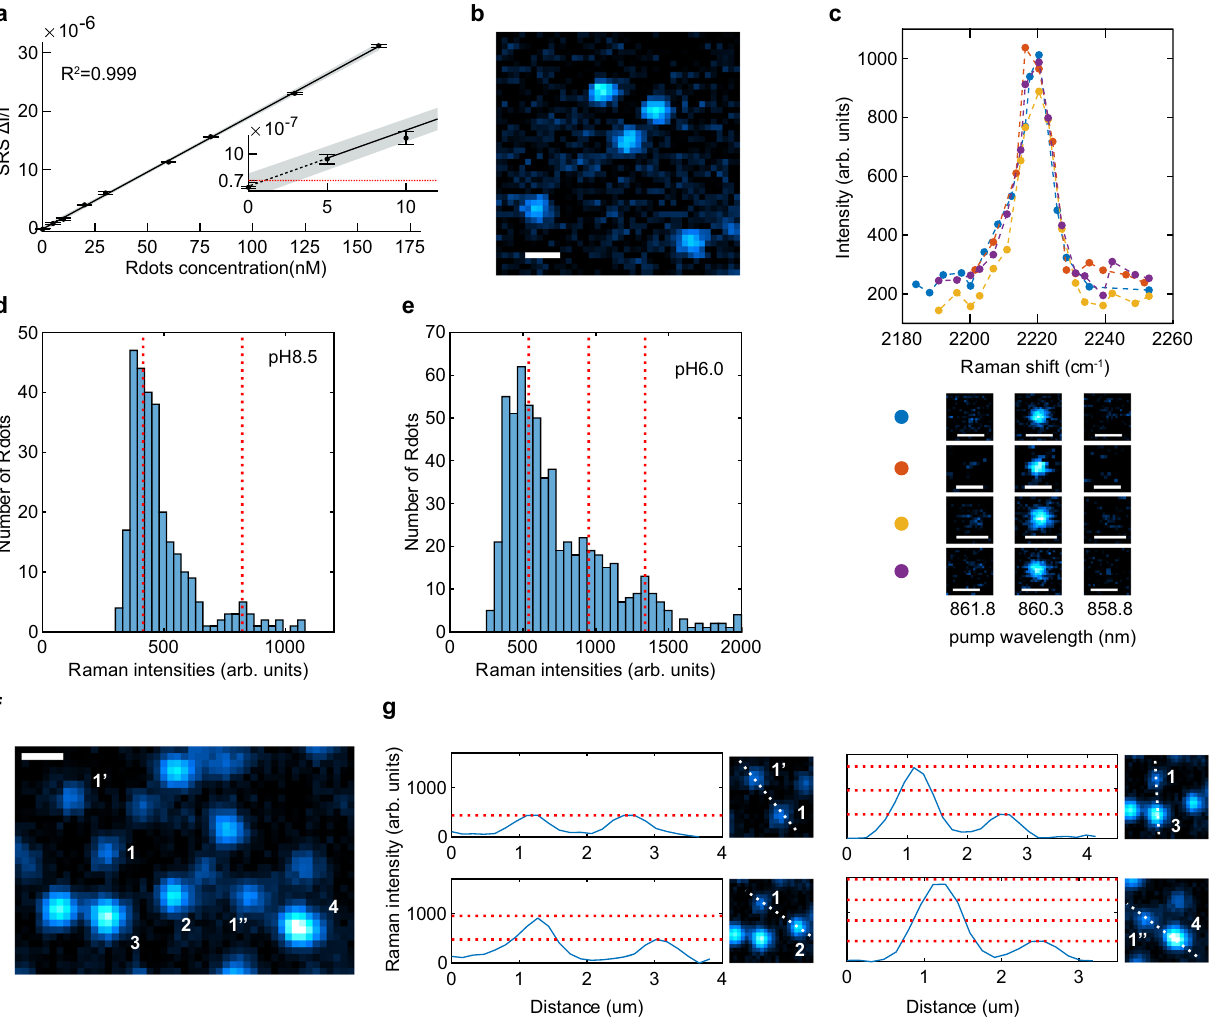
Fig. 3 Evidence for single-particle sensitivity of Rdots under SRS microscopy. a Linear concentration dependence of Rdots with sub-nM SRS detection sensitivity. Red dashed line in the insert indicates shot-noise-limited SRS detection limit where SNR = 1. Error bars, mean ± s.d.; n = 3 measurements. Solid line shows a linear fi tting ( R 2 = 0.999), shaded area indicates 95% con fi dence interval of the linear fi tting. arb. units: arbitrary units. b A representative image of potential single-particle spots. Scale bar: 1 µ m. c Raman spectra of ‘ single ’ Rdots2220 acquired by SRS microscopy by sweeping the pump wavelength. The original SRS images below at three marked pump wavelengths show the signal can be tuned off by only 1.5 nm. The spectra are in consistence with bulk measurements of Rdots by spontaneous Raman spectroscopy. Scale bar, 1 µ m. arb. units: arbitrary units. d SRS intensity distribution of individual spots at pH 8.5. Red dash lines indicate fi tted peak positions. The quantized distribution suggests spots corresponding to single-particle and double-particle aggregates. n = 289 from 7 replicates. e SRS intensity distribution of individual spots at pH 6.0. Red dash lines indicate fi tted peak positions. The quantized distribution suggests spots corresponding to single-particles, double-particle aggregates, and triple-particle aggregates. n = 595 from 6 replicates. arb. units: arbitrary units. f A representative image of spots from single-particles and multi-particle aggregates. 1, 1 ’ , and 1 ” : single-particle; 2: double-particle; 3: triple-particle; 4: quadruple-particle. Scale bar: 1 μ m. g Line pro fi les across spots in f . Quantized signal intensity is evidently observed. arb. units: arbitrary